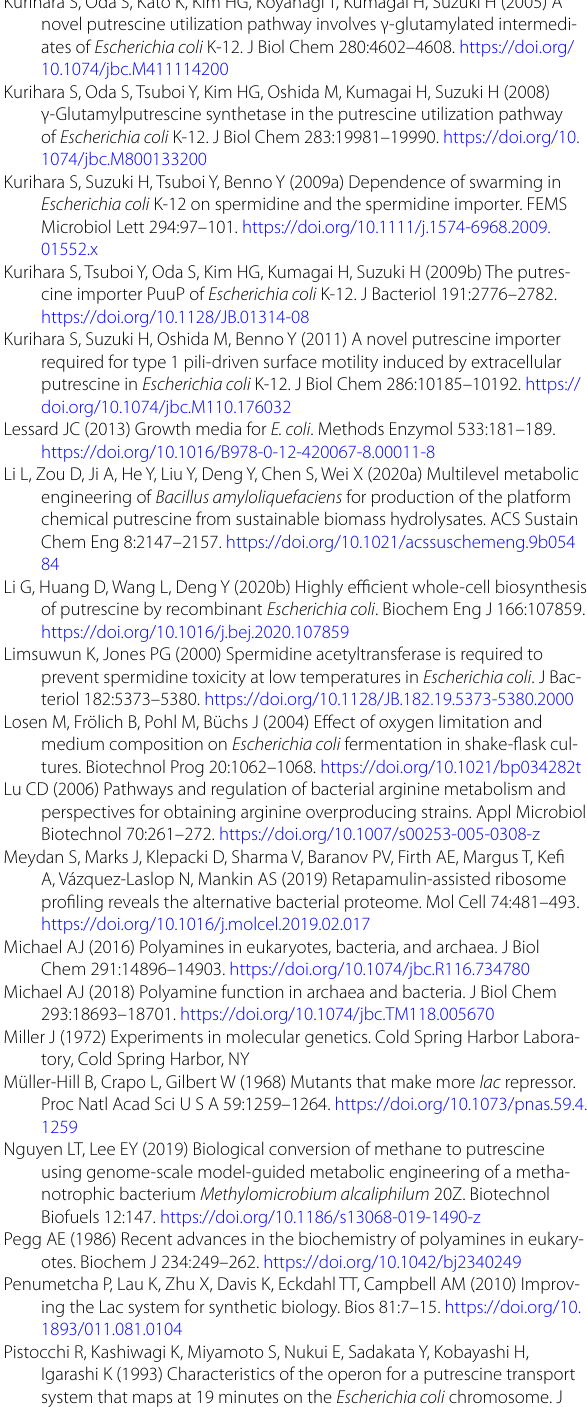
Tabor CW, Tabor H (1985) Polyamines in microorganisms. Microbiol Rev 49:81–99 Tabor CW, Tabor H, Xie QW (1986) Spermidine synthase of Escherichia coli : localization of the speE gene. Proc Natl Acad Sci U S A 83:6040–6044. https:// doi. org/ 10. 1073/ pnas. 83. 16. 6040 Terui Y, Saroj SD, Sakamoto A, Yoshida T, Higashi K, Kurihara S, Suzuki H, Toida